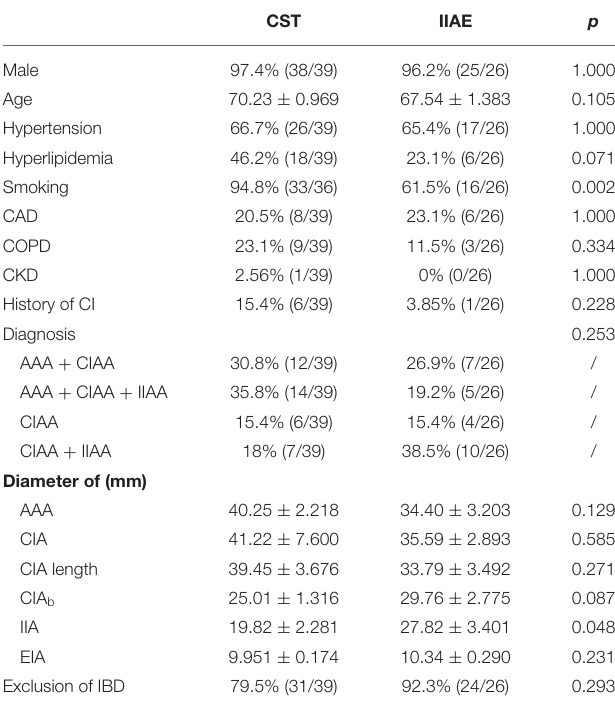
TABLE 1 | Demographics and preprocedural